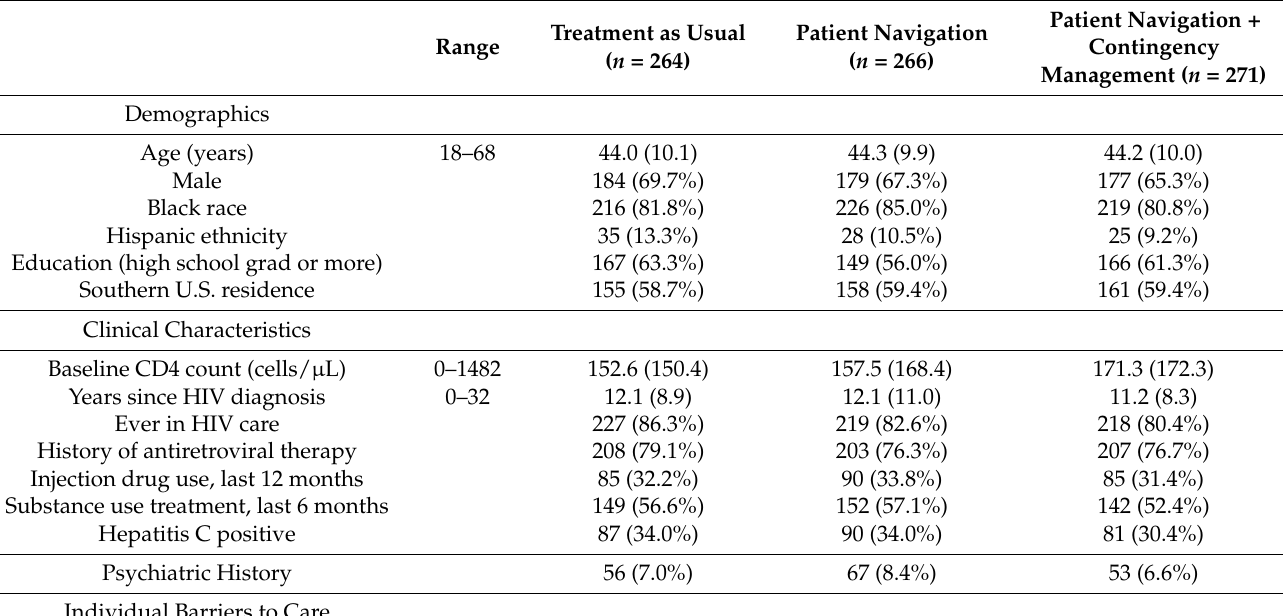
Table 1. Characteristics of the CTN-0049 study sample ( n =